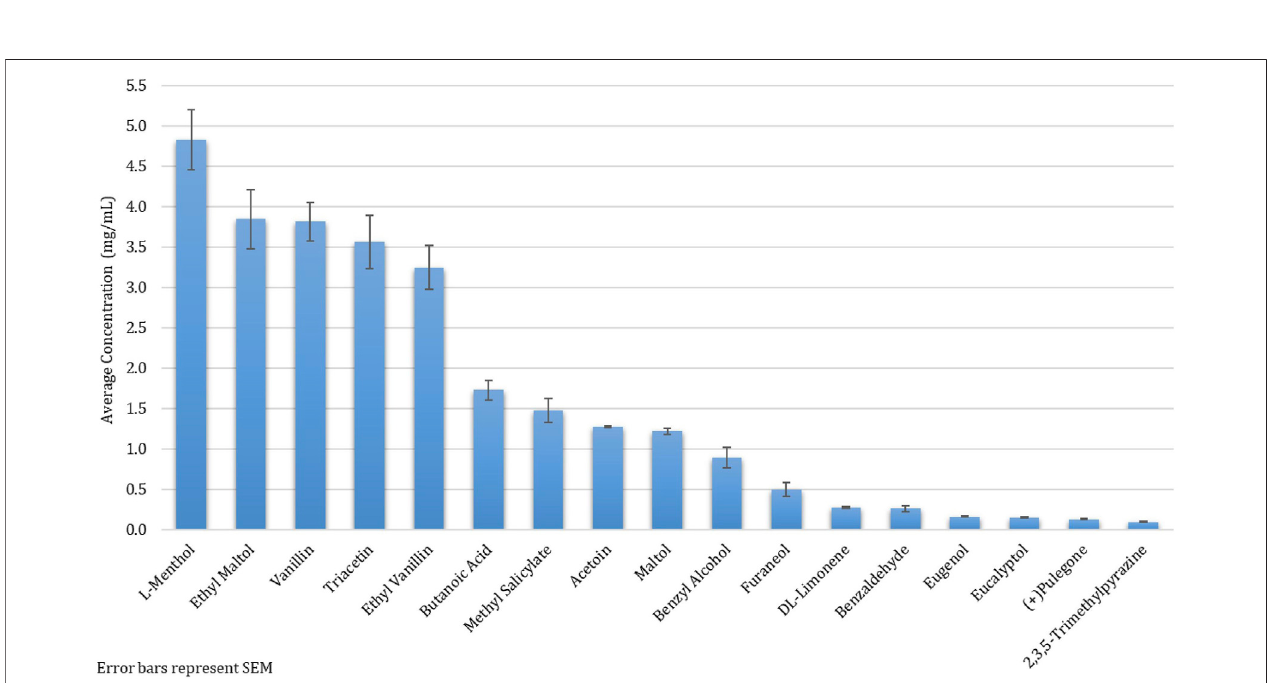
FIGURE 4 | Average Concentration of Twenty Flavoring Chemicals found in 215 Selected Commercial Flavored E-Cigarette Liquids.